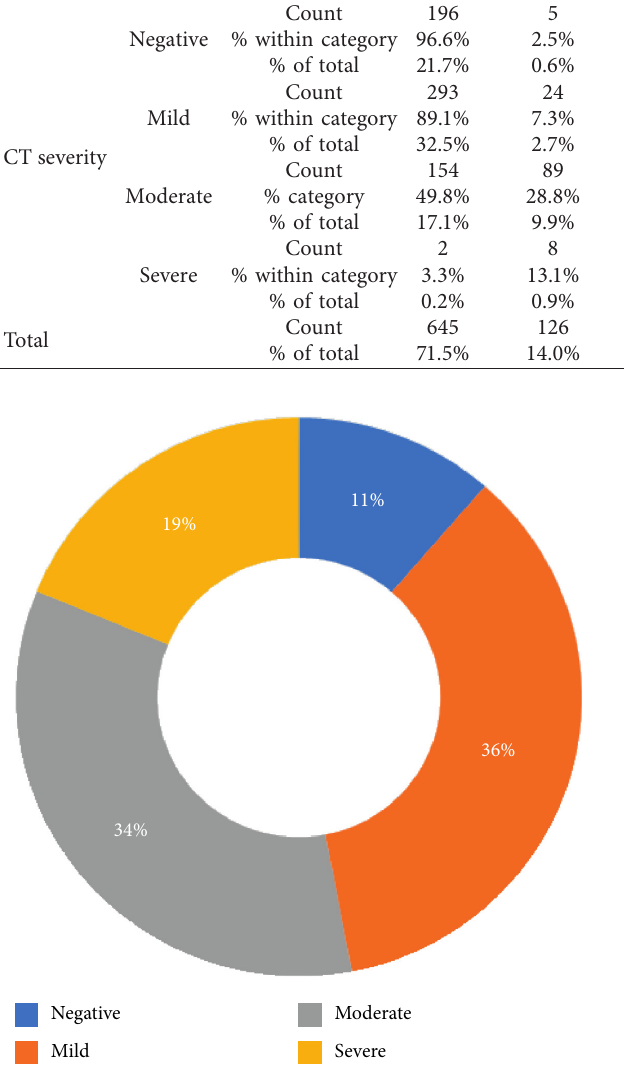
Figure 3: Percentage of patients admitted to the ICU in each CT severity